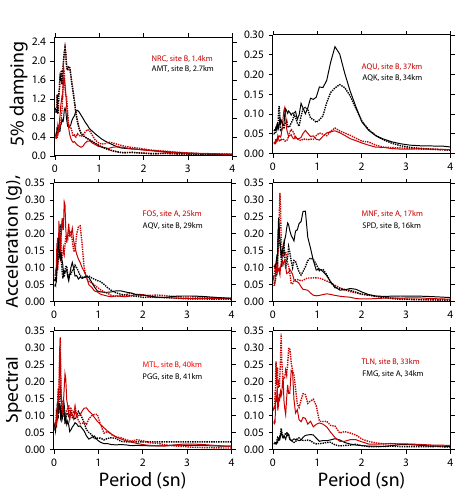
Figure 5. Comparison of the acceleration response spectra at 5% damping ratio for two horizontal com- ponents (EW dashed line and NS solid line) registered at the stations that are located in forward (red lines) and backward (black lines) directivity